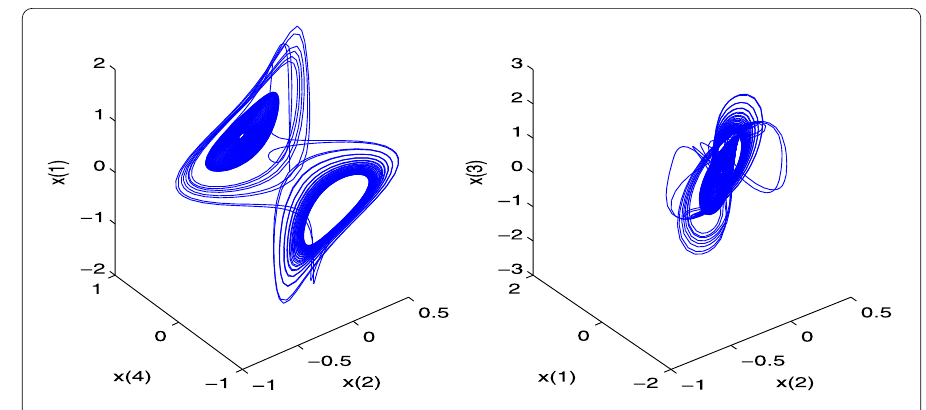
Figure 2 Memristor-based hyperchaotic attractors: 3D